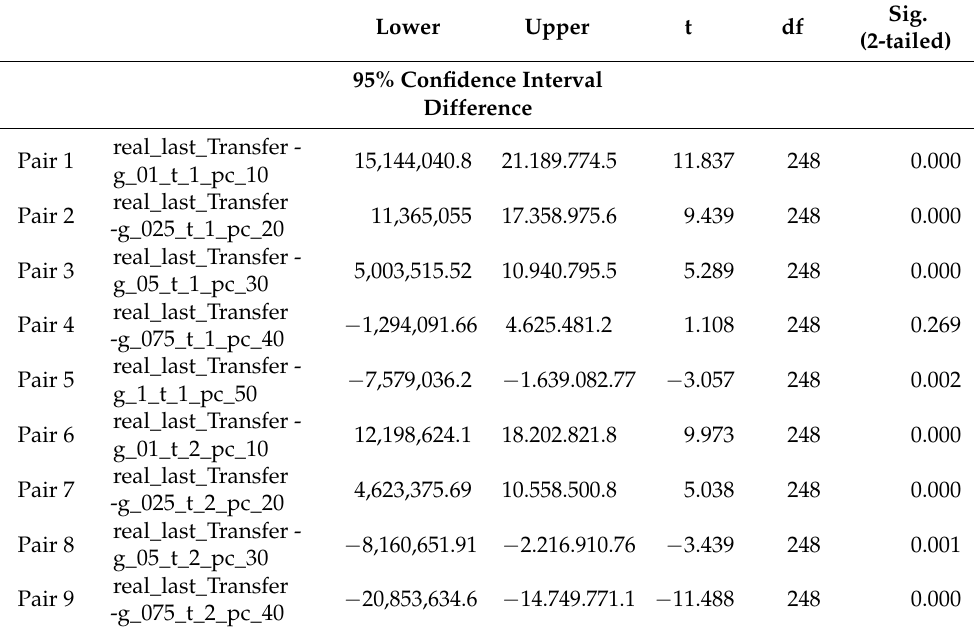
Table 6. Sample comparison test of transfer values, part